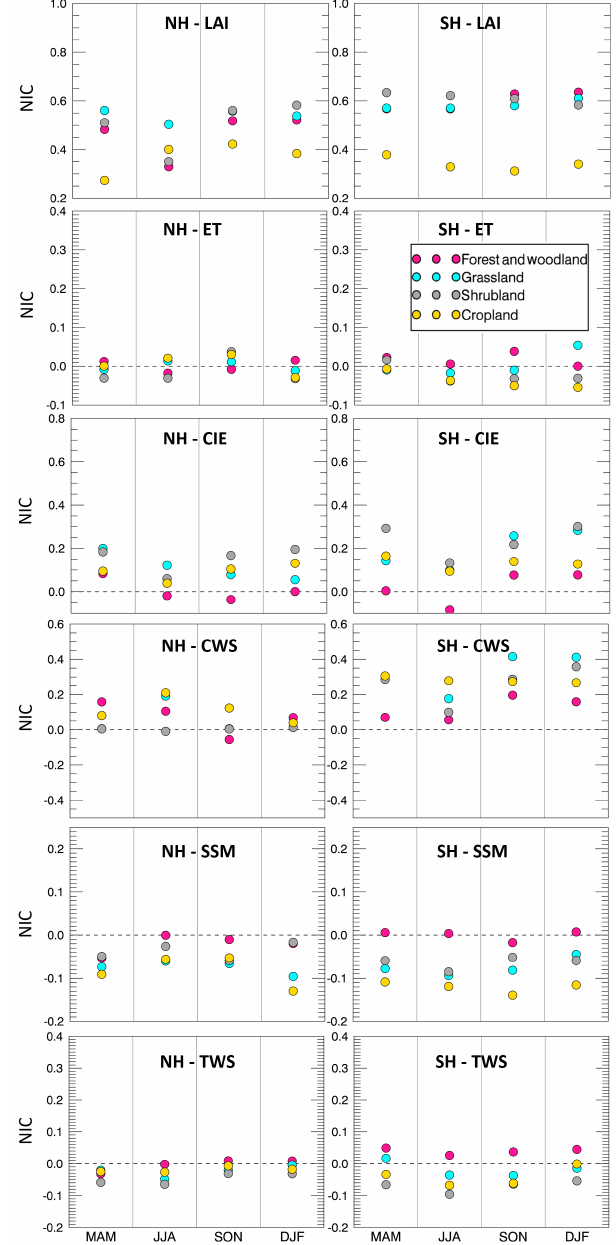
Figure 9. The NIC of five water variables under wet precipitation conditions over Northern and Southern hemispheres (NH and SH, respectively) during the different seasons (MAM, JJA, SON, and DJF).